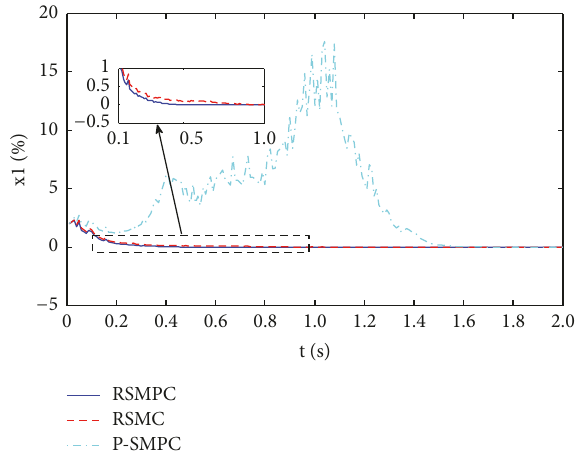
Figure 9: Response curves of system state 𝑥 1 under disturbance condition